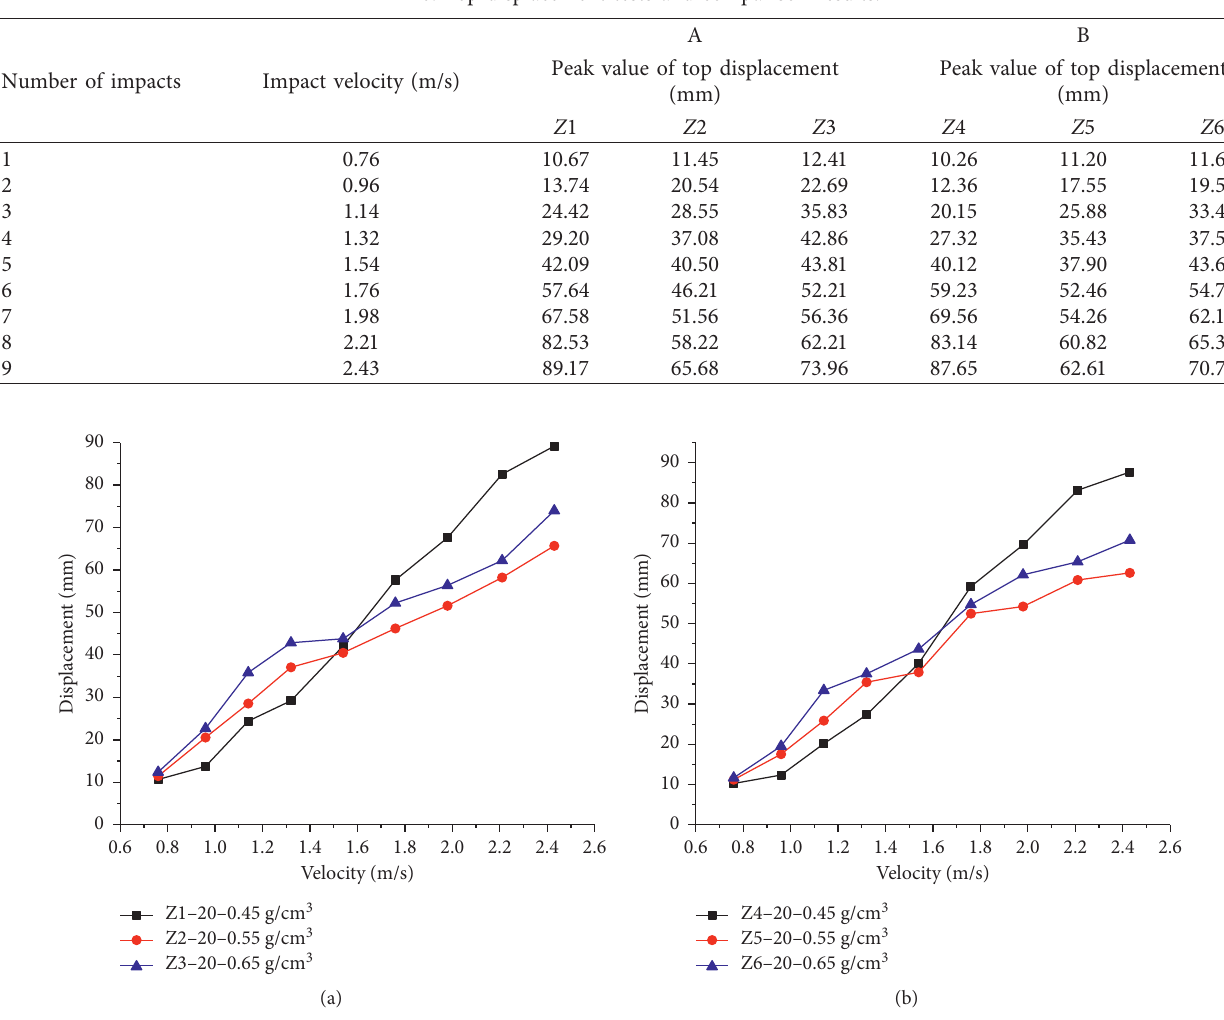
Table 6: Top displacement tests and comparison results.